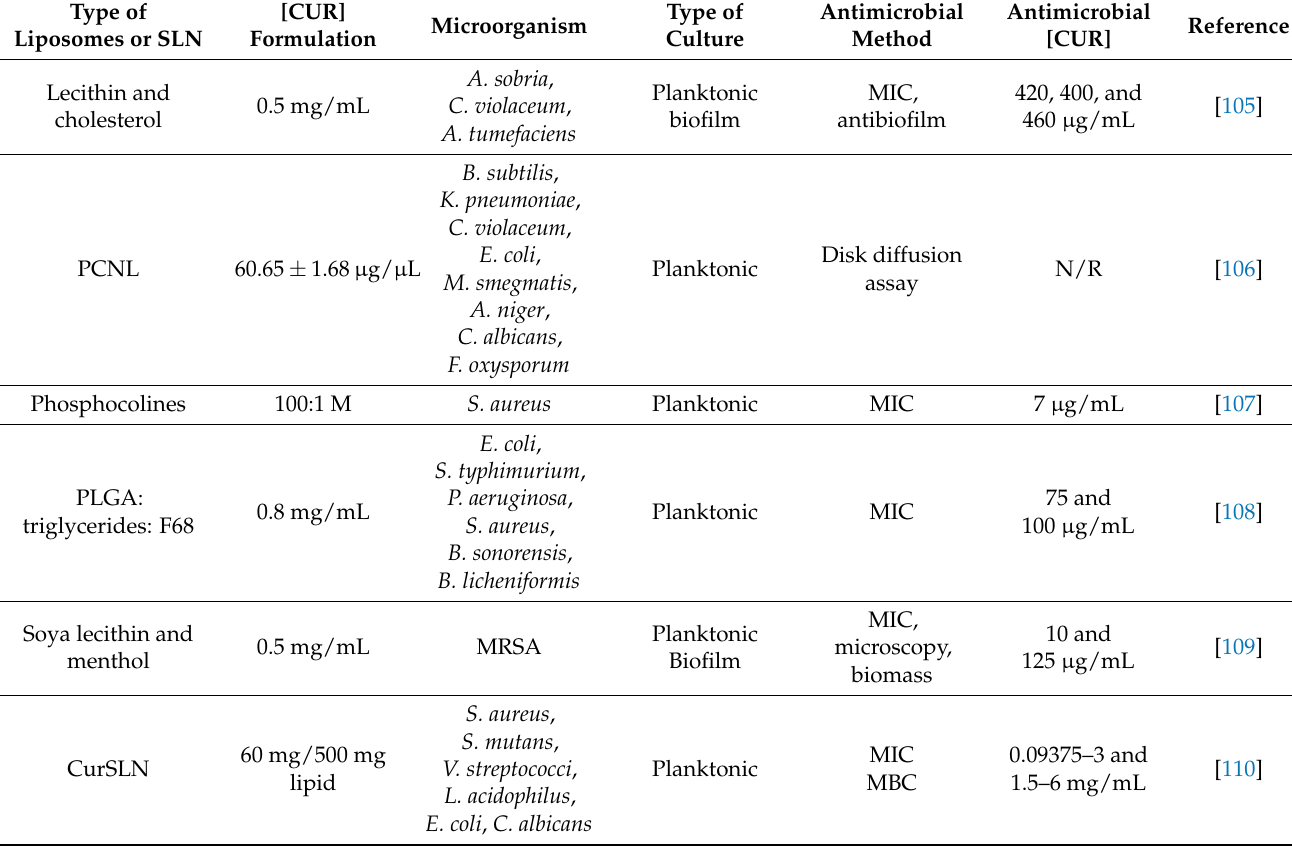
Type of Antimicrobial Antimicrobial Reference Culture Method [CUR]